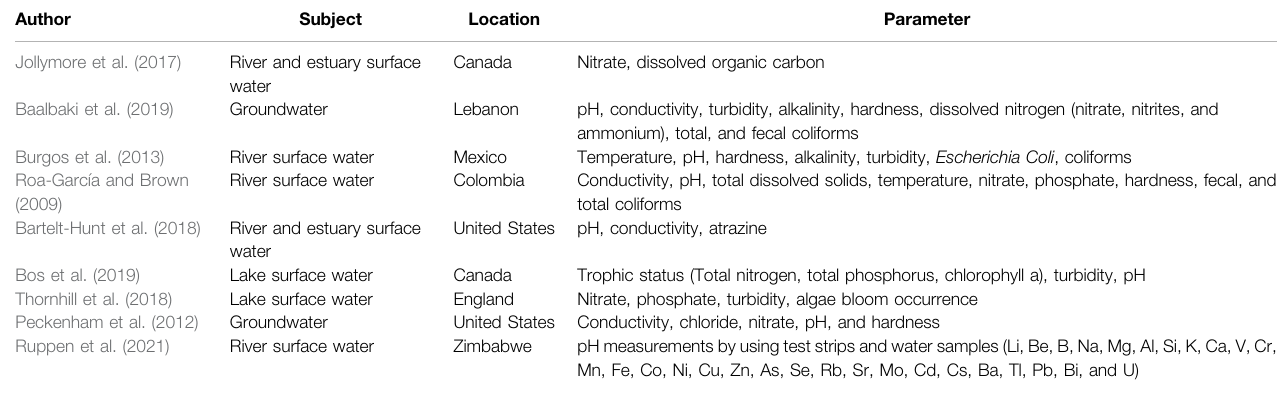
TABLE 1 | Community monitoring studies of water quality around the